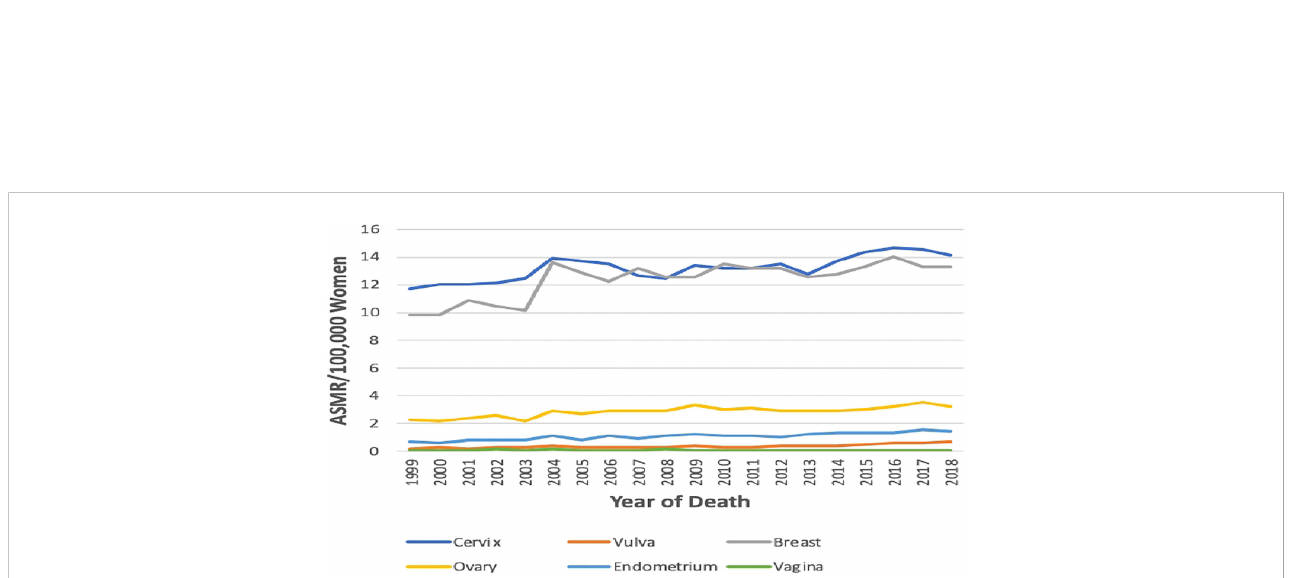
FIGURE 1 Trends in national and ethnic annual deaths (A) , age-standardized rates (B) , and crude mortality rates (C) of breast cancer in South Africa (1999 –